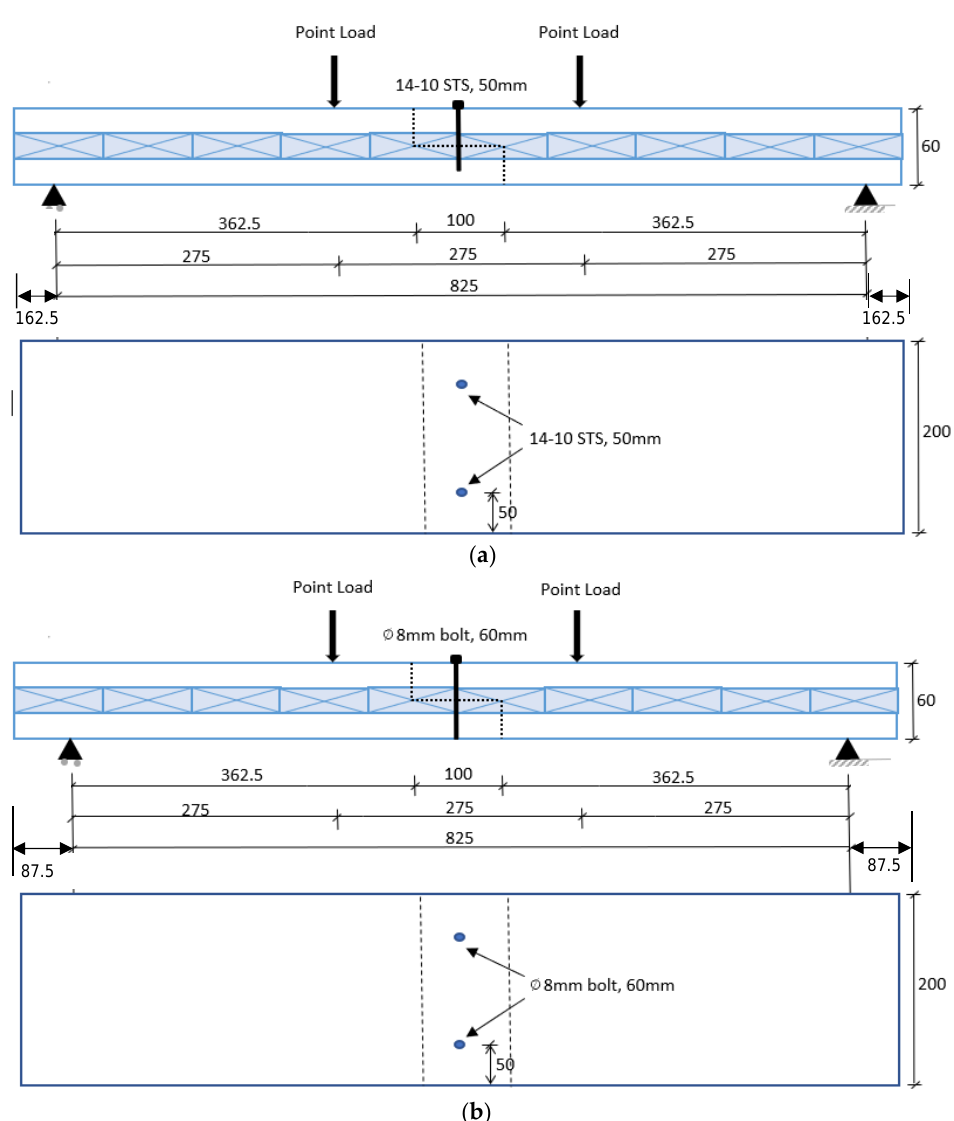
Figure 1. Bending test on the half-lap CLT connection: ( a ) STS-connected and ( b ) bolt-connected. Figure 2 demonstrates a spline connection system used in the study. Splines were bolt-connected to the bottom face of the CLT specimens only. To make the single spline connections, three different types of splines, e.g., steel plates with a thickness of 3 and 8 mm, and plywood plates with a thickness of 17 mm, were selected. A total of 4 bolts were installed on each plate. The plywood plates were connected to CLT members in two ways: (i) with bolts only and (ii) glue plus bolts. Two separate bolt diameters (6 and 8 mm) were used to investigate the effect of bolt diameter on the performance of connections. Bolts were installed in the spline connection in the same manner as were for the lap connection. Table 1 presents the details of the test matrix considered in the current study. A total of 11 variations of CLT connections comprising lap and spline were tested, where 4 were related to lap connection and 7 were part of spline connection. For each variation of the connection, at least three samples were tested. Moreover, flexural capacities of spline con- nections along both the major and minor axis of the CLT specimen were tested, as shown in Figure 2a,b.